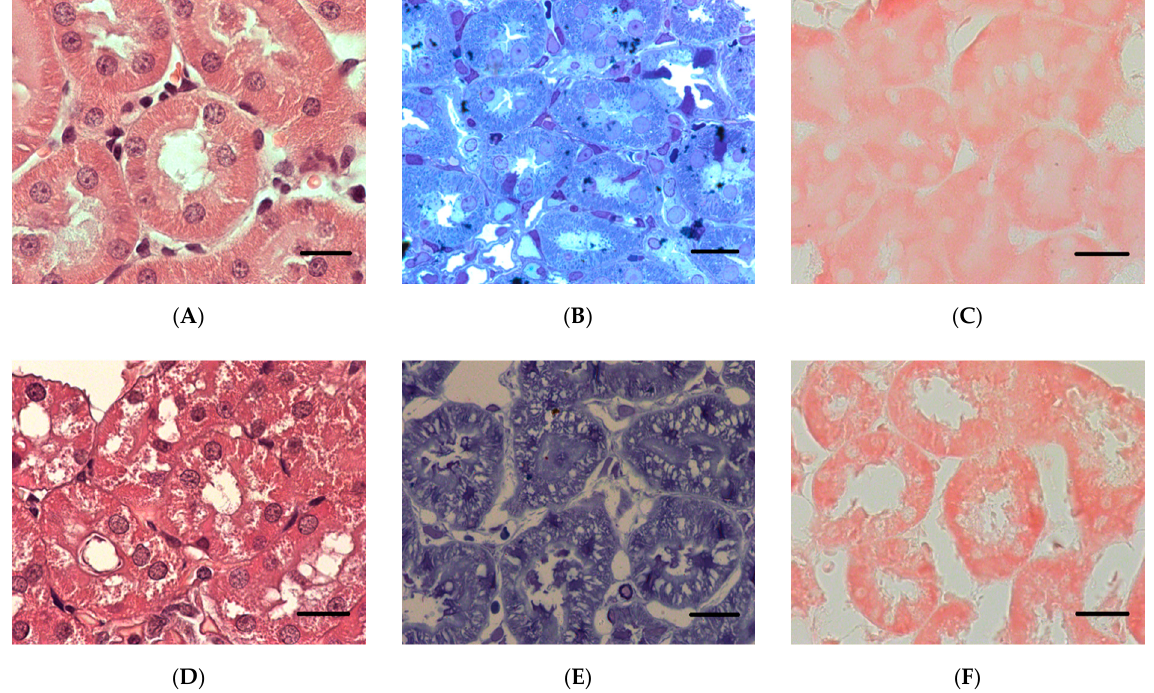
Figure 9. Epithelium of rat renal cortex tubules. ( A – C )—control; ( D – F )—24 h after exposure to POX (LD84). H&E stain ( A , D ); methylene blue stain ( B , E ); IHC to nephrin, fast red chromogen ( C , F ). (×1000). Scale bar = 10 µm.